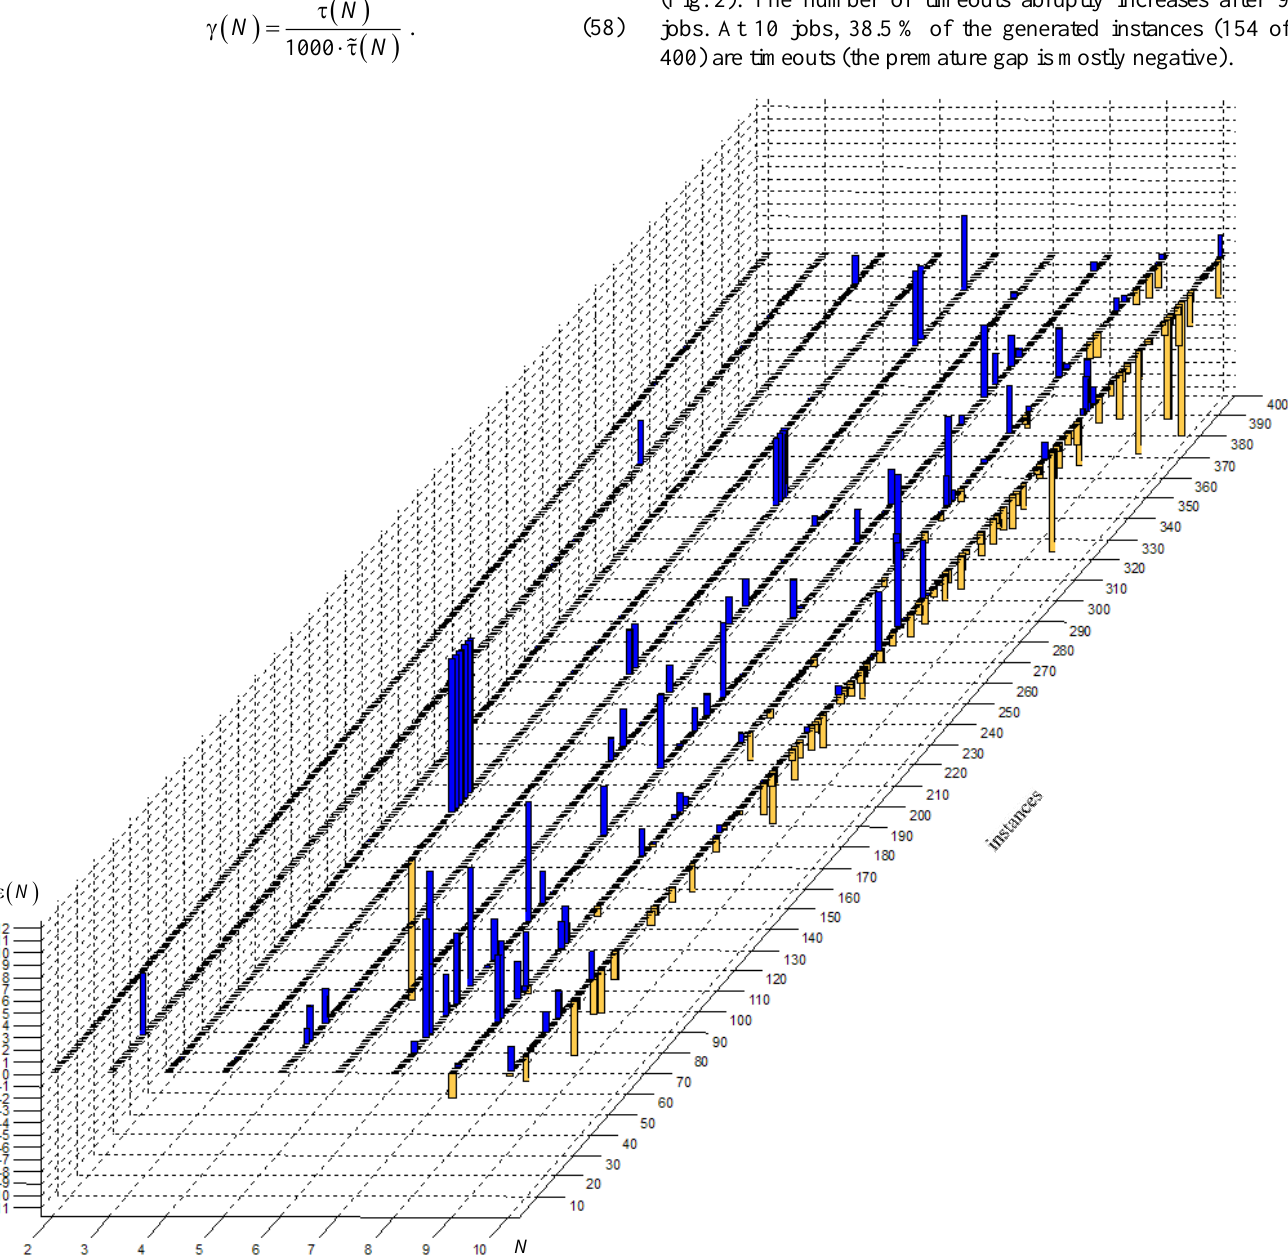
Fig. 1. Common gap (52), where negative gaps are barred with a lighter colour. The heuristic has returned each of 400 schedules of 2 jobs with the respective minimal TWT. While scheduling 3 and 4 jobs, the heuristic “erred” only two times (the gaps in 5.13 % and 3.63 %) and once (the gap in 2.33 %), respectively. In scheduling 5 jobs, seven instances have been generated in a row (128, 130, 132, 133, 135, 137, 138) with the gap in 12.57 %. It is a pseudorandomness